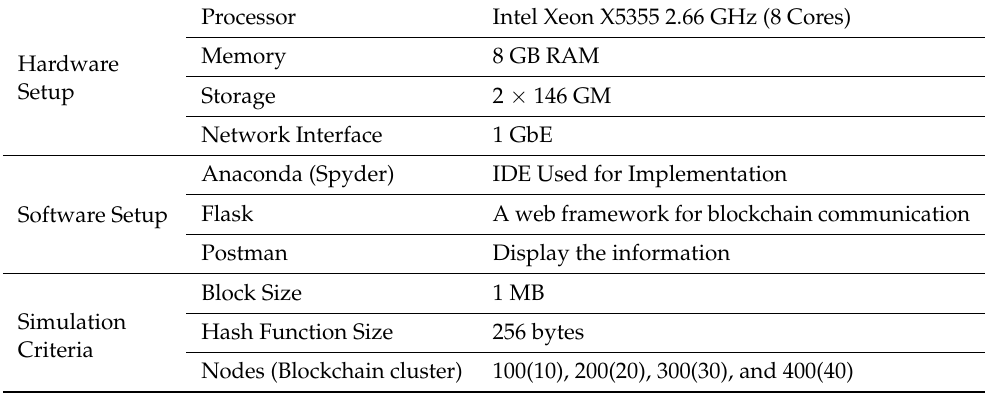
Table 2. Experimental